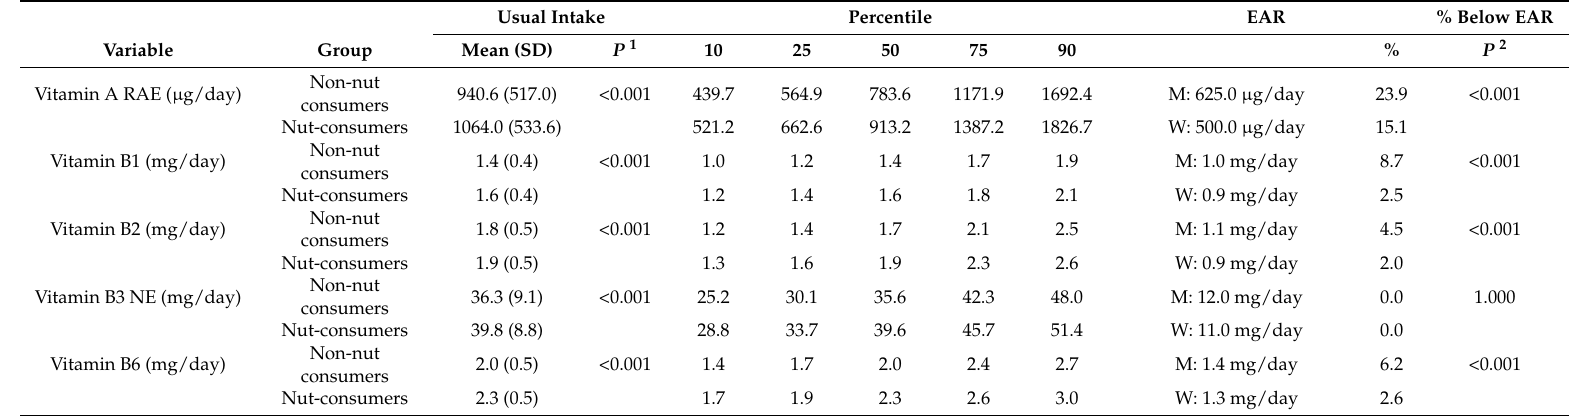
Table 2. Usual intake and percentage of population below the estimated average requirement (EAR) or above adequate intake (AI) in nut-consumers ( n = 4969) compared with non-nut consumers ( n =